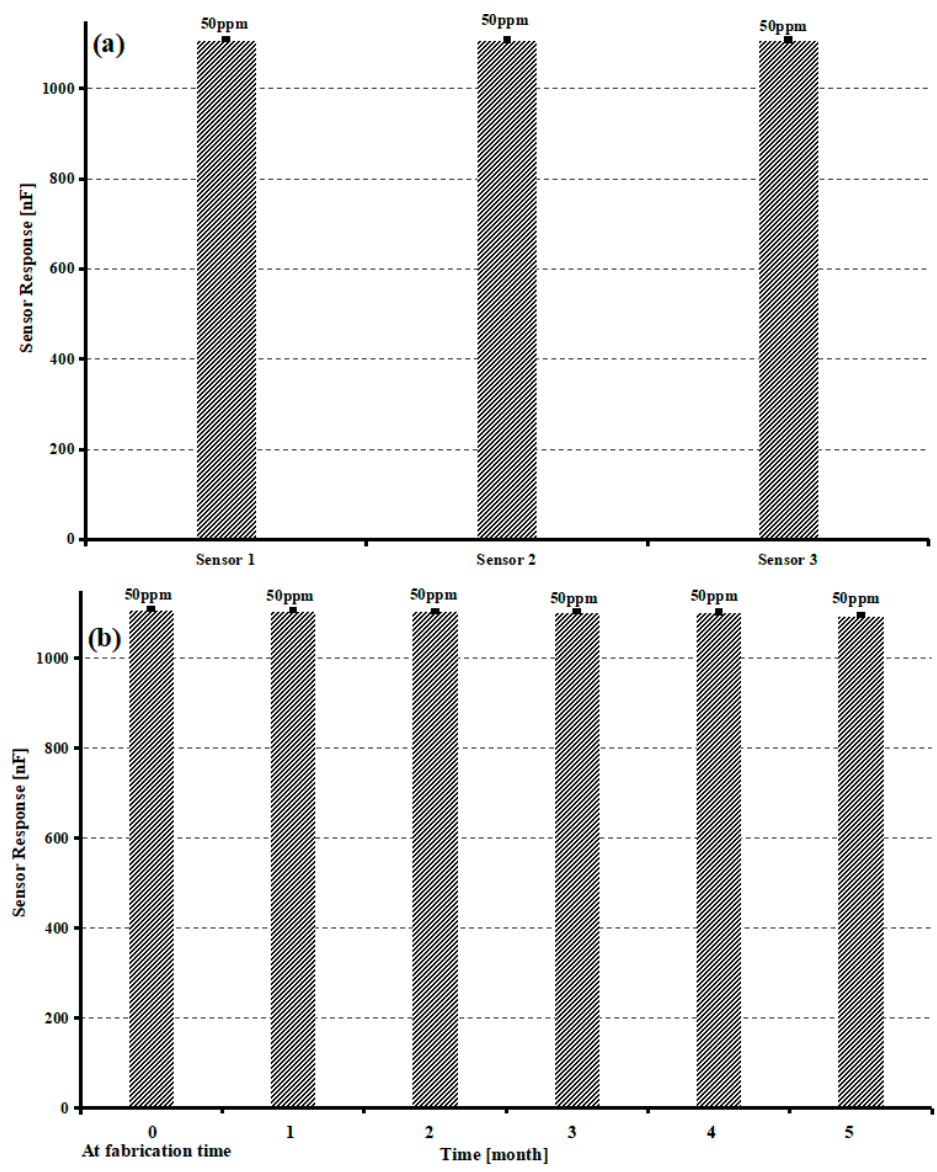
Figure 10. ( a ) Repeatability and stability profile of fG-sucrose (composite) ( b ) sensor over the period of 6 months.